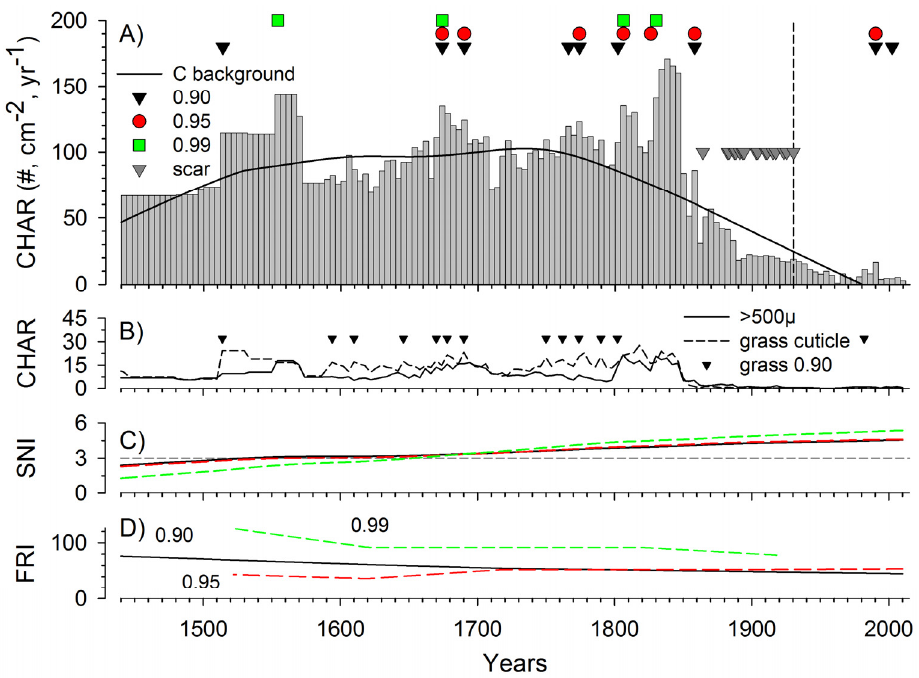
Figure 10. C interpolated (four years) with C background curve using a 300-year window ( A ). The fire events identified using the 0.90, 0.95, and 0.99 thresholds are identified. The gray triangles indicate fire years determined from fire scars occurring in two or more trees. The vertical dashed line indicates the establishment of Riding Mountain National Park. The contributions of grass cuticle morphotype and that of charcoal particles above 500 microns are also indicated, as well as the fire events identified in the former at the 90th percentile ( B ). The signal to noise ratio with SNI = 3 threshold value (short dashed grey line); ( C ) and the fire return intervals (600 years smoothing) associated to each threshold ( D ) are also indicated.